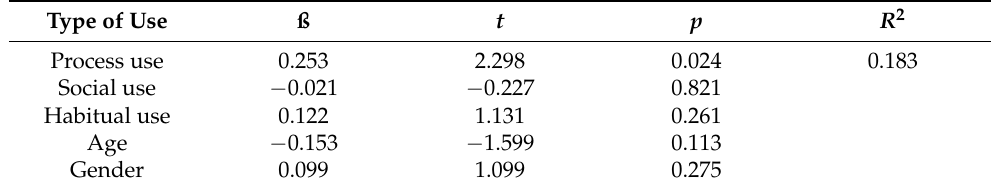
Table 4. Predictors of stress perception ( N = 108).